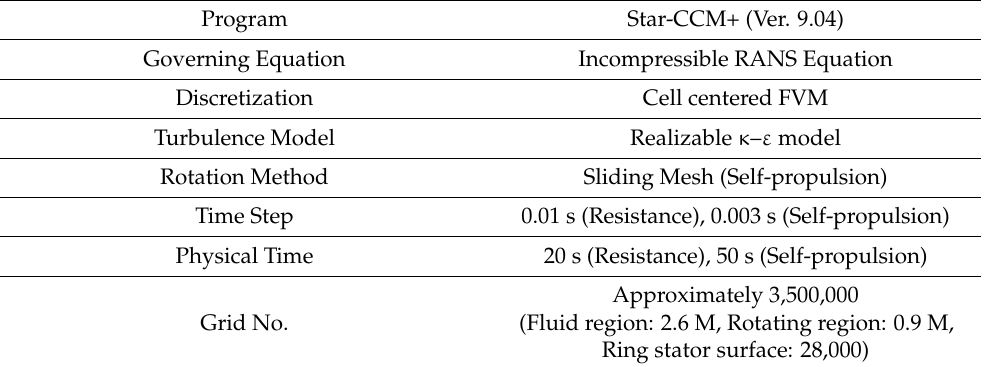
Figure 5. Grid system for CFD. Table 1. Computational conditions for CFD.